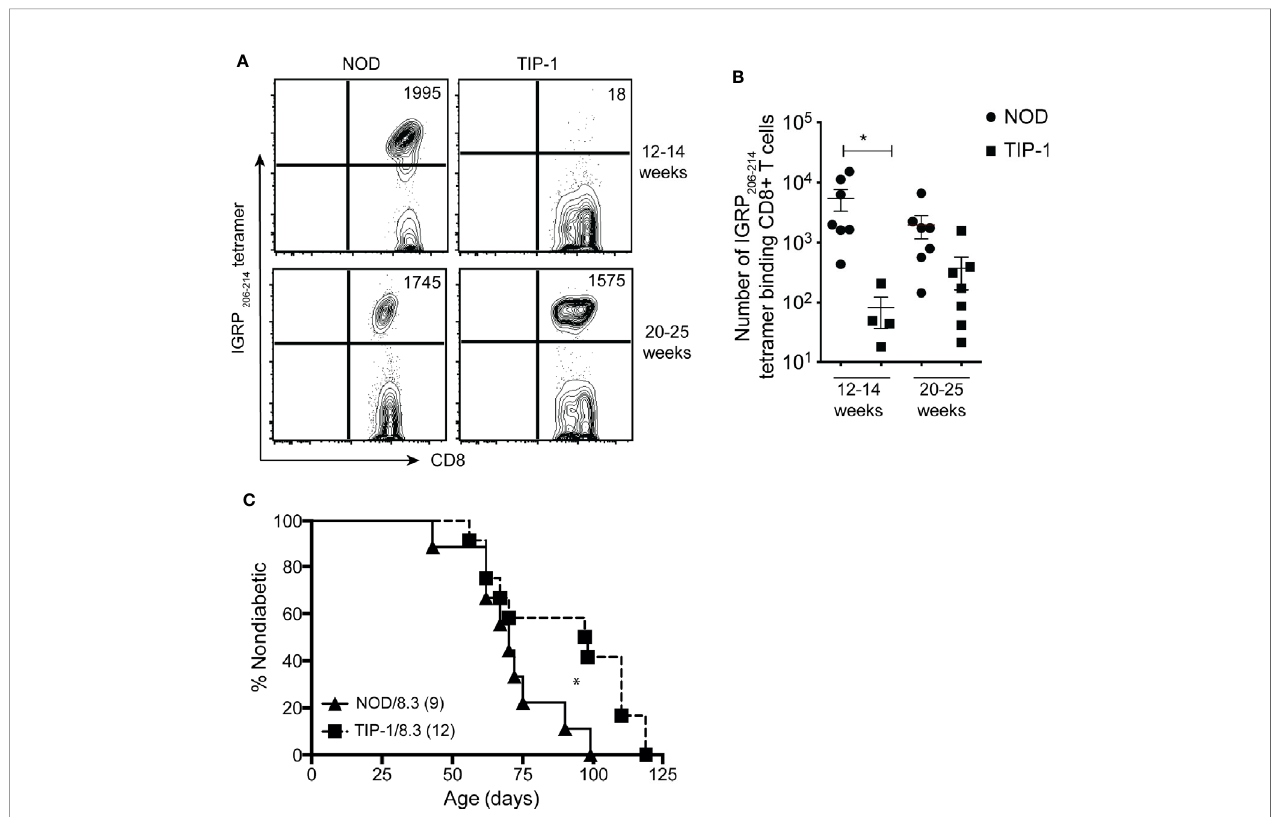
FIGURE 5 | Enumeration of IGRP speci fi c CD8+ T cells in TIP-1 mice IGRP 206-214 -speci fi c CD8+ T cells were stained with Kd- IGRP tetramer and enriched from pooled peripheral lymphoid organs (PLO) of 12-14 weeks and 20-25 weeks old NOD mice and TIP-1 mice. Representative FACS plots (A) and quanti fi cation (B) of absolute number of IGRP 206-214 tetramer + CD8+ T cells at indicated ages. Values in the FACS plots indicate absolute number of tetramer binding cells. Each symbol in the scatter plots (Mean ± SEM) represents data from an individual mouse. *P<0.05, data in (B) compared using one-way ANOVA with Sidak ’ s multiple comparisons test. (C) Incidence of spontaneous diabetes in female TIP-1/8.3 mice and NOD 8.3 littermates. Numbers in parentheses indicate the number of mice analyzed. *P < 0.05. Survival curves were compared using log-rank (Mantel-Cox)